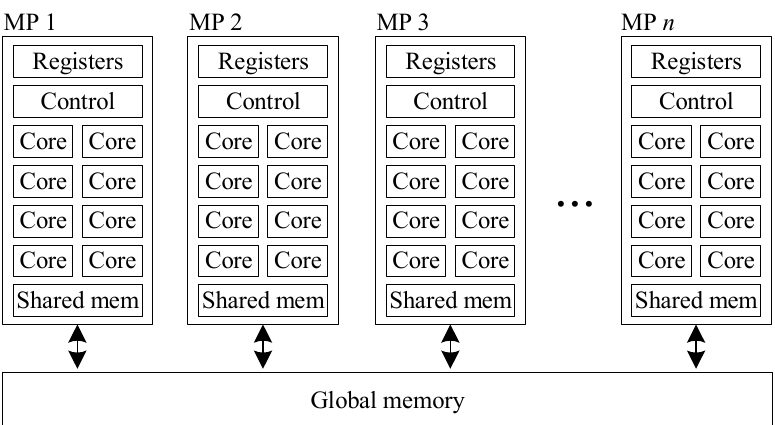
Figure 1. Simplified architecture of an NVIDIA GPU.